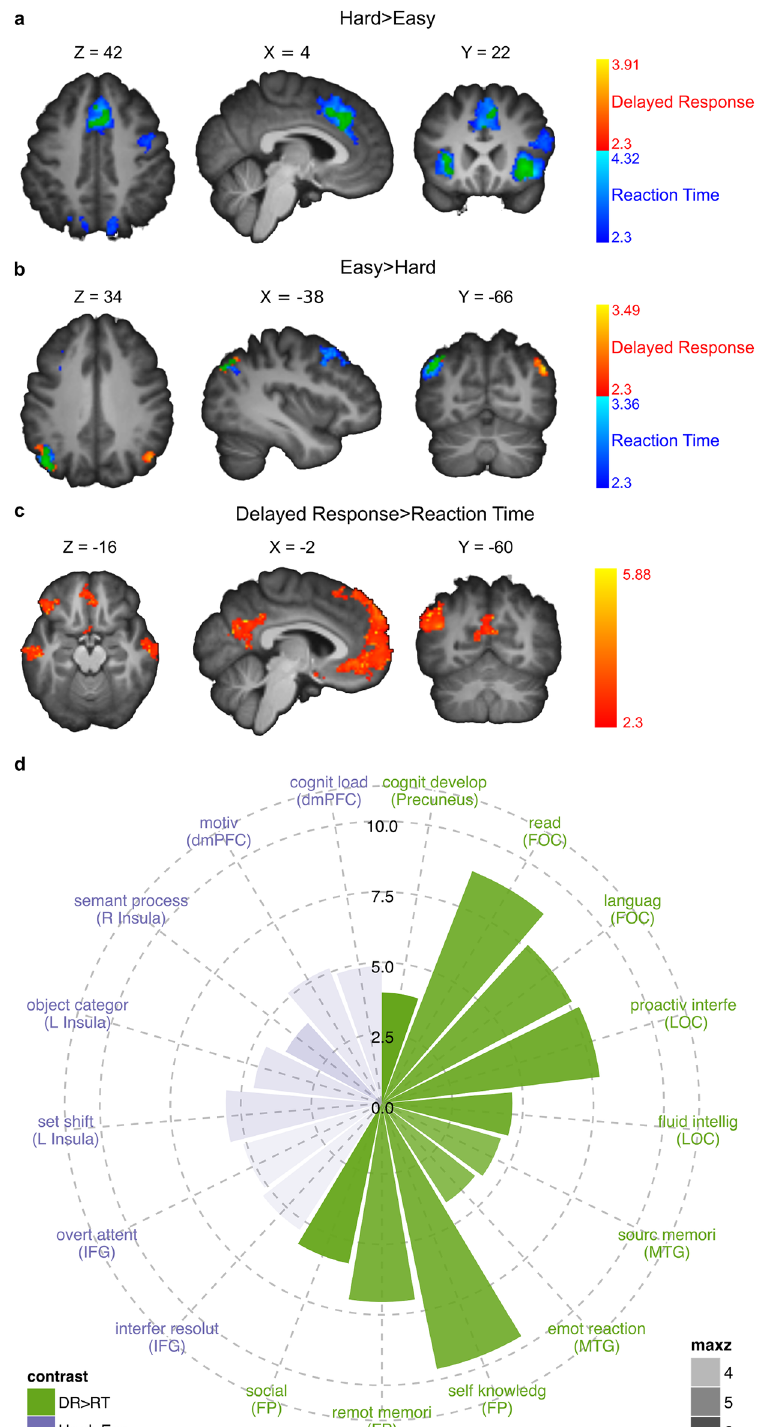
Fig 5. Cluster activations and polar plot. Cluster activations for hard > easy (A) and easy > hard (B) contrasts for reaction time (RT) (blue) and delayed response (DR) (red) with overlapping activations in green. Threshold at Z > 2.3, cluster corrected to p < 0.05 with 3dClustSim. (C) Cluster activations for DR > RT contrast, whole-brain corrected for multiple comparisons at p < 0.05 with cluster threshold at Z > 2.3. (D) Posterior probabilities of terms describing psychological functions. In purple are terms with high posterior